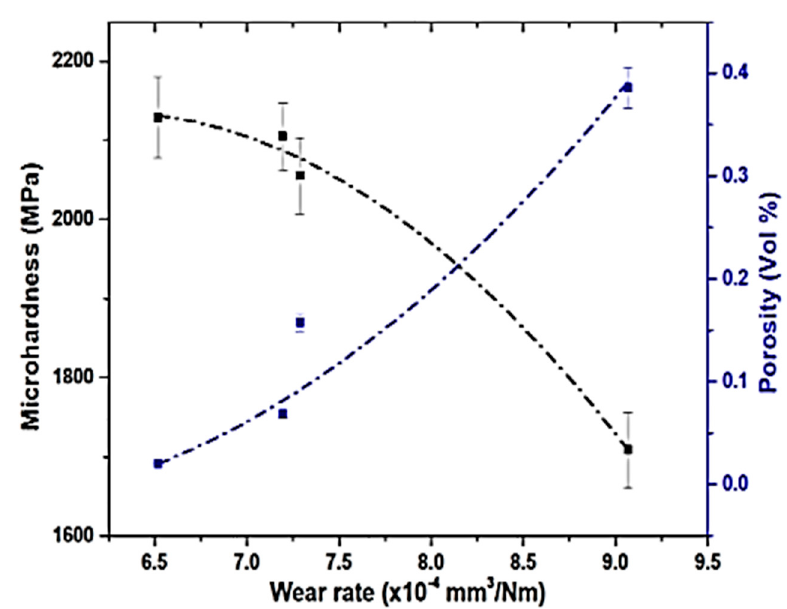
Figure 13. Microhardness and porosity as a function of wear rate of NiTec, coatings as a function of microhardness and porosity.